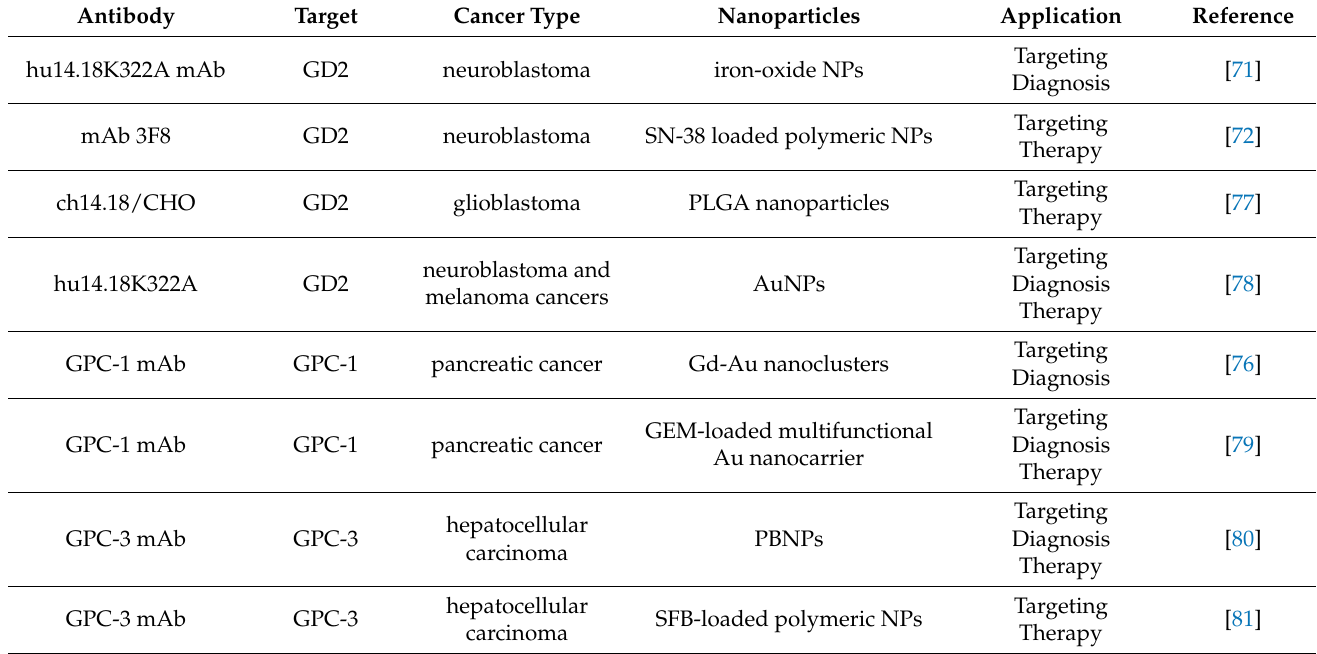
Table 2. Nanoparticles functionalized with monoclonal antibodies (mAbs) targeting aberrant cancer-associated glycans. Abbreviations: poly lactic-co-glycolic acid (PLGA); gadolinium (Gd); gemcitabine (GEM); prussian blue nanoparticles (PBNPs); sorafenib (SFB); glypican-3